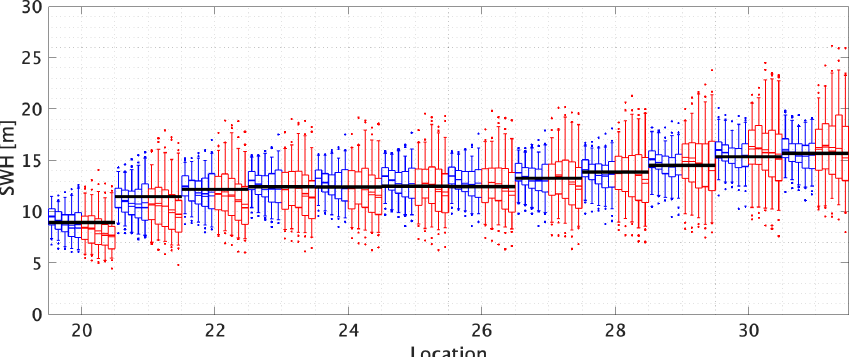
Figure 9. The 500-year return value for SWH estimated using probability-weighted moments for the line transect. The x axis gives the reference numbers of the 12 locations on the transect. Briefly, for each location, blue and red box–whiskers summarize the estimated return value from STM-E and single-location analysis respectively; see caption of Fig. 6 for other details. The black horizontal lines for each location correspond to the empirical estimate of the return value obtained directly from the full synthetic cyclone data for each location. Water depths at the 12 line transect locations are given in the caption to Fig. 2.